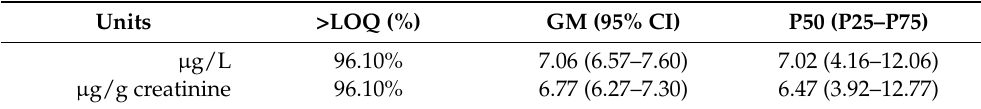
Table 1. BPA levels in urine samples of Italian children ( N = 900). The percentage of the samples > LOQ, the geometric mean (GM) with the 95% Confidence Interval (CI) and the median (P50) with the interquartile range (P25-75) are reported, for both unadjusted ( µ g/L) and creatinine-adjusted urinary concentrations ( µ g/g).